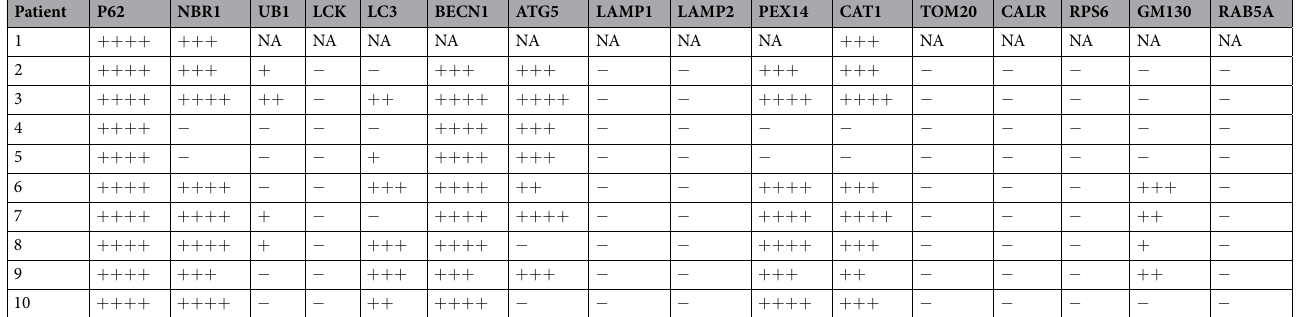
Table 2. Results of ECI immunostaining. Notes: − , all ECIs were negative; + , 1–25% ECIs were positive; ++